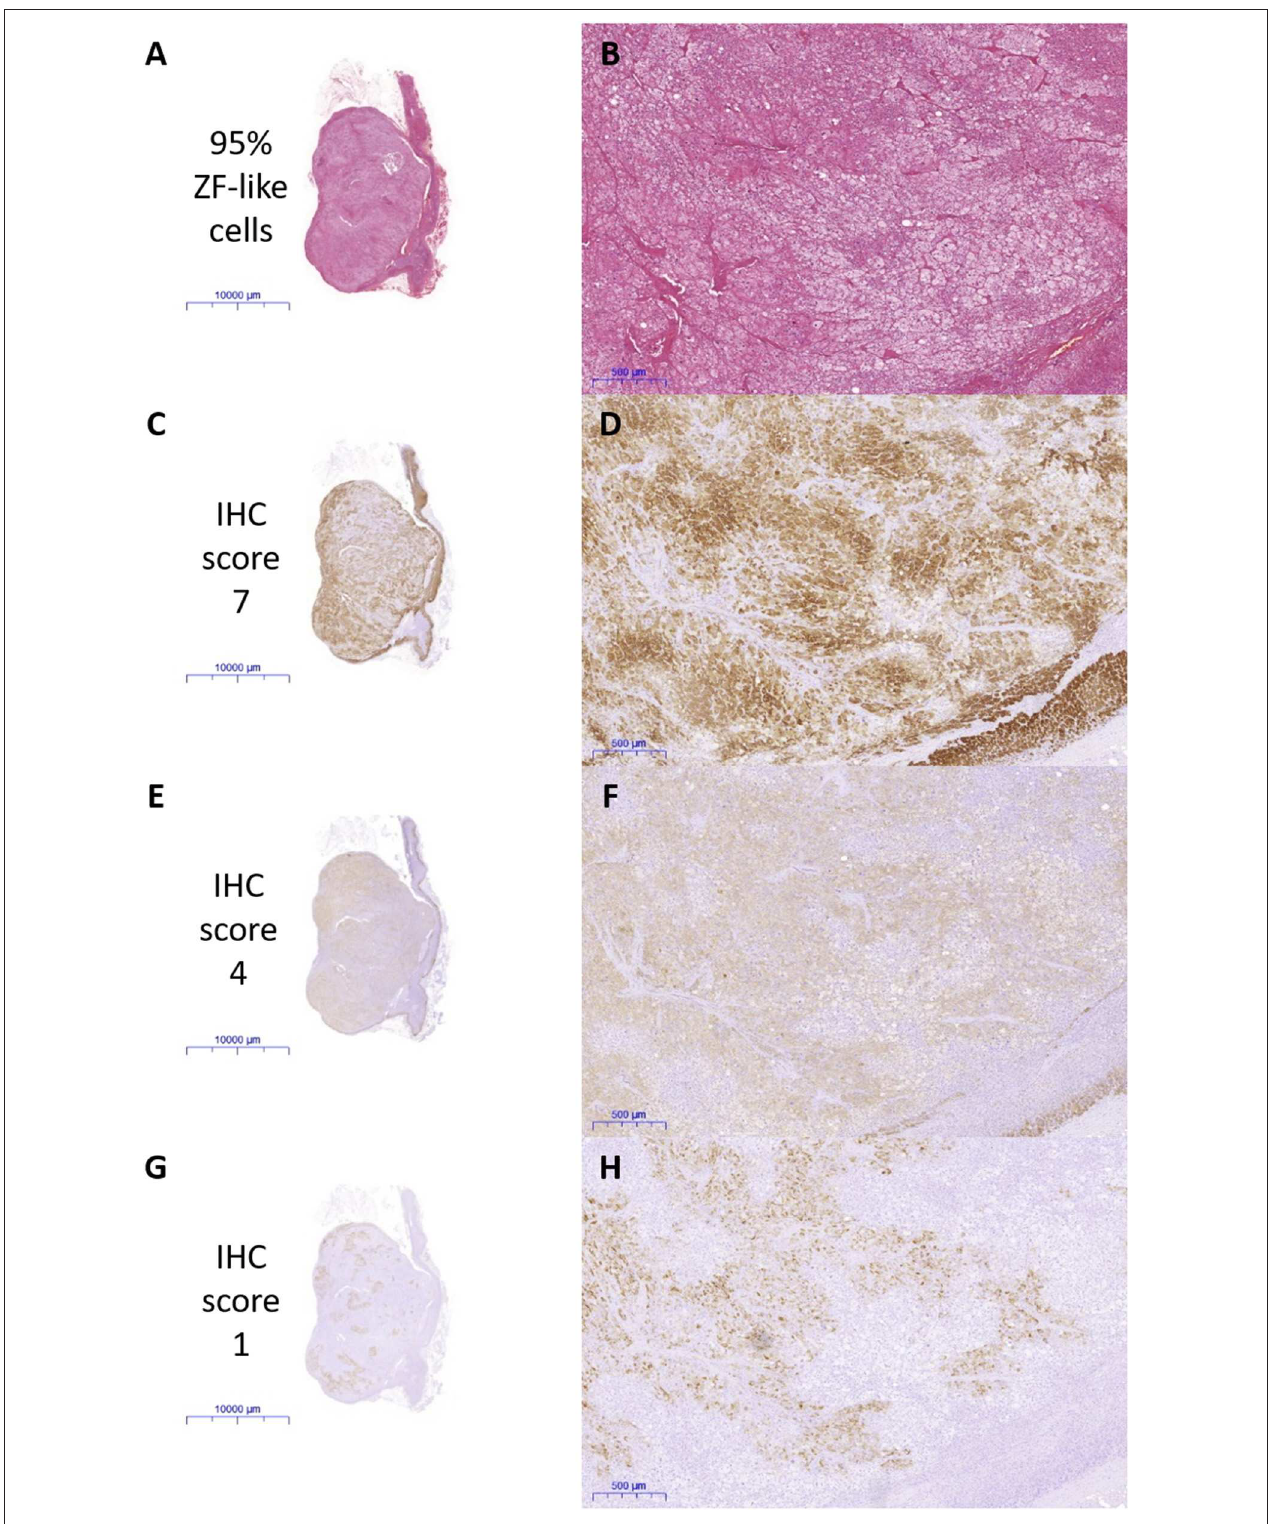
FIGURE 1 | Representative scan and microscope images of the immunohistochemical (IHC) staining scored by a blinded histopathologist. (A,B) Percentage of ZF-like cells, (C,D) IHC staining of CYP17A1, (E,F) IHC staining of KCNJ5 , and (G,H) IHC staining of CYP11B2.